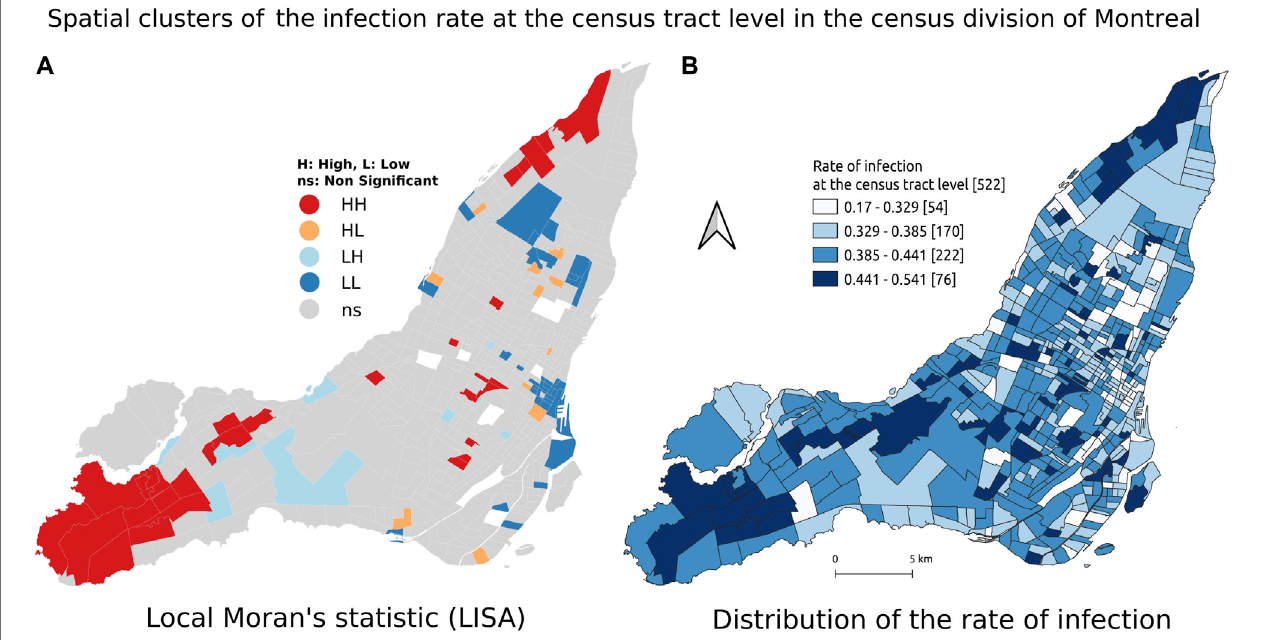
FIGURE 12 | Spatial clusters of the infection rate at the census tract level in Montreal. Panel (A) : local Moran ’ s statistic at p (cid:1) 0 . 05.Panel (B) : spatial distribution of the infection rate.